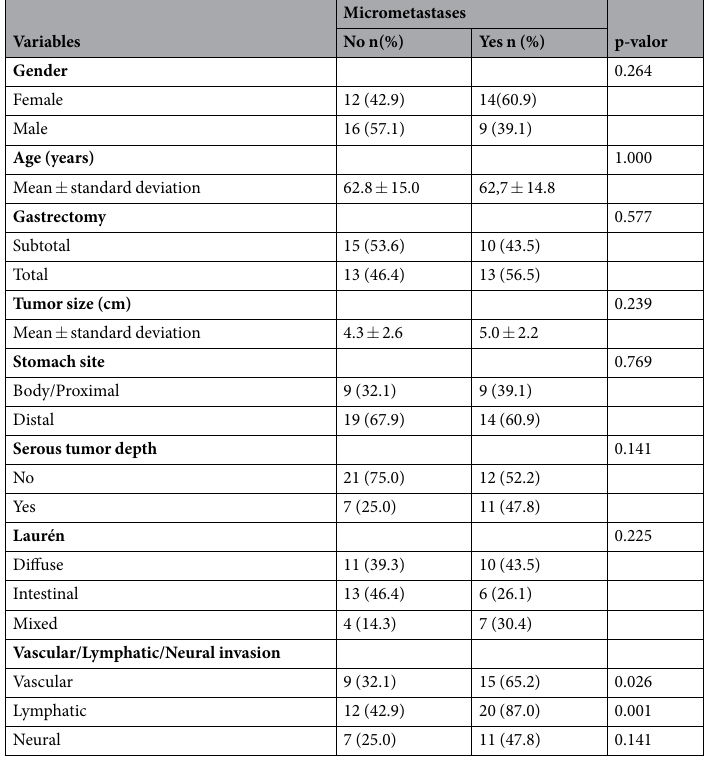
Table 5. Comparison of the different variables in patients submitted to radical gastrectomy about the presence of micrometastases in gastric carcinoma (n = 51). p-test significant when < 0.05. It was shown that 60% of the advanced gastric cancer patients had micrometastases compared to 12,5% of the early gastric cancer group (p =